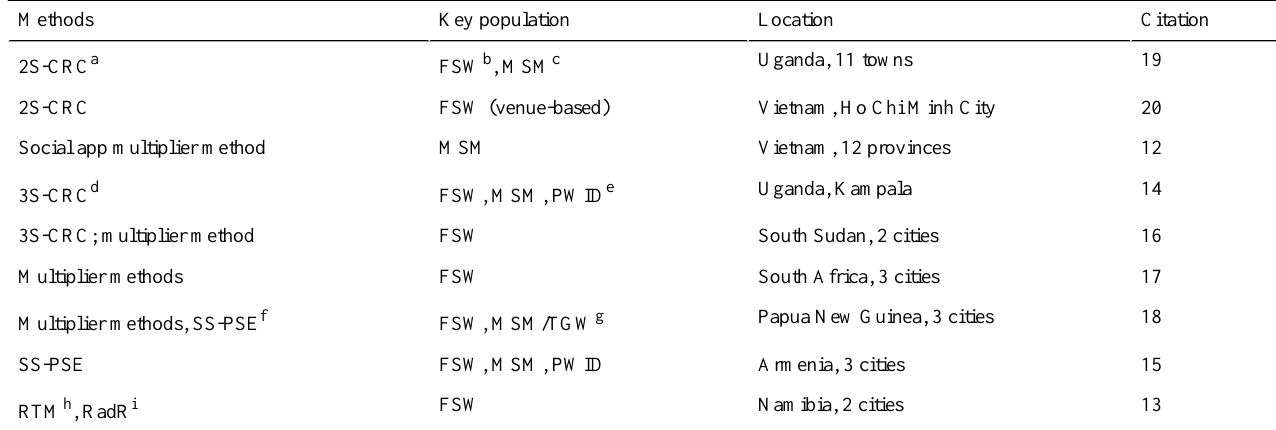
Table 1. Population size estimation methods, key populations, and geographic location covered by papers in the special-themed